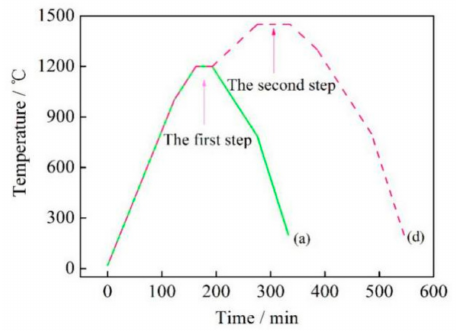
Figure 1. Sintering curves of a and d : ( a ) 1200 ◦ C, 30 min; ( d ) 1450 ◦ C, 60